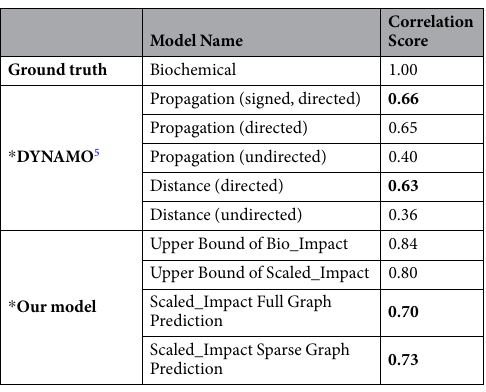
Table 1. Overall results on perturbation pattern prediction, 0.66 is the best performance of DYNAMO, 0.63 is the accuracy of distance model. 0.70 and 0.73 are the accuracies of our proposed enhancement methods on distance